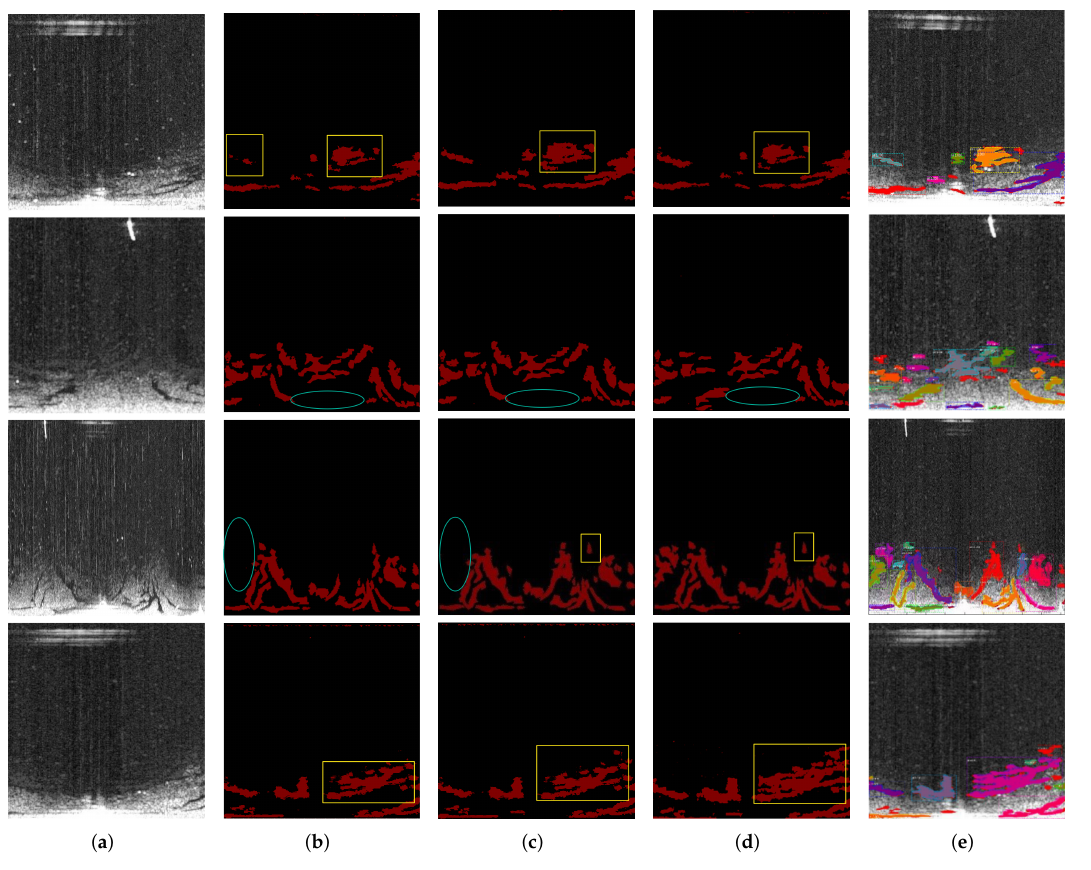
Figure 12. The segmentation results of different module experiments: ( a ) The image, ( b ) PSPNet, ( c ) DeepLab V3+, ( d ) Attention u-net, and ( e ) FPN + soft attention + FCN. The rectangles mark the oil spill regions where segmentation was not accurate, and ovals mark oil spill regions that were